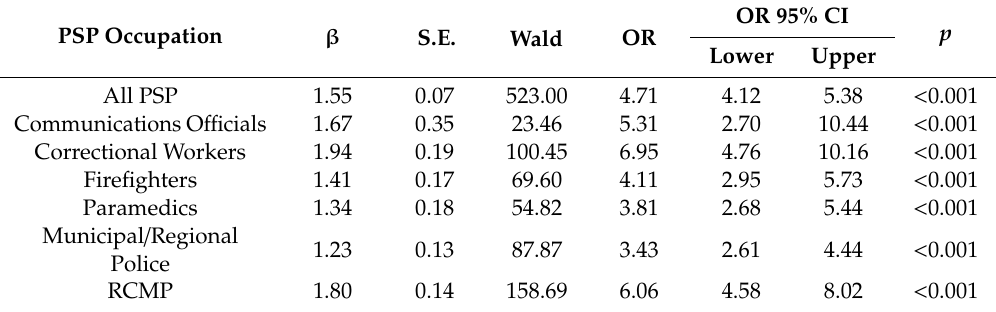
Table 4. Logistic Regression for Positive Screens of Any Current Mental Disorder on Insomnia by PSP Group. PSP Occupation β S.E. Wald OR